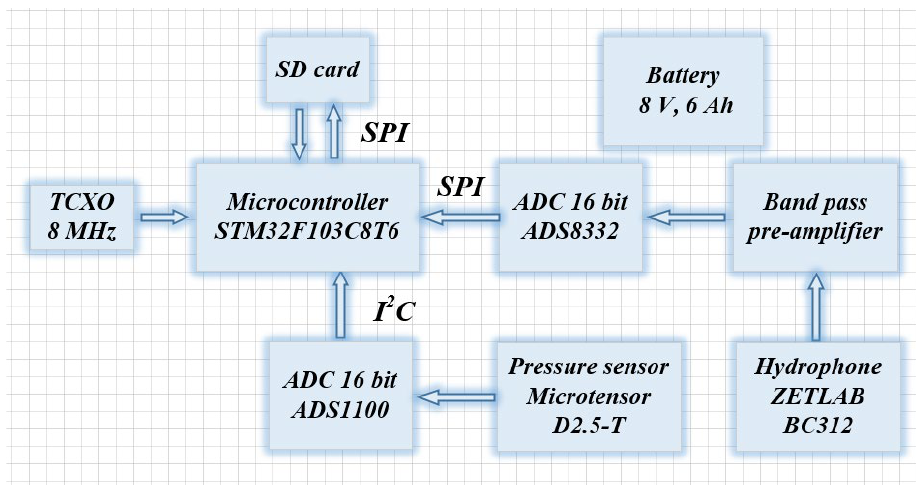
Figure 9. Block diagram of a stand-alone digital recorder.